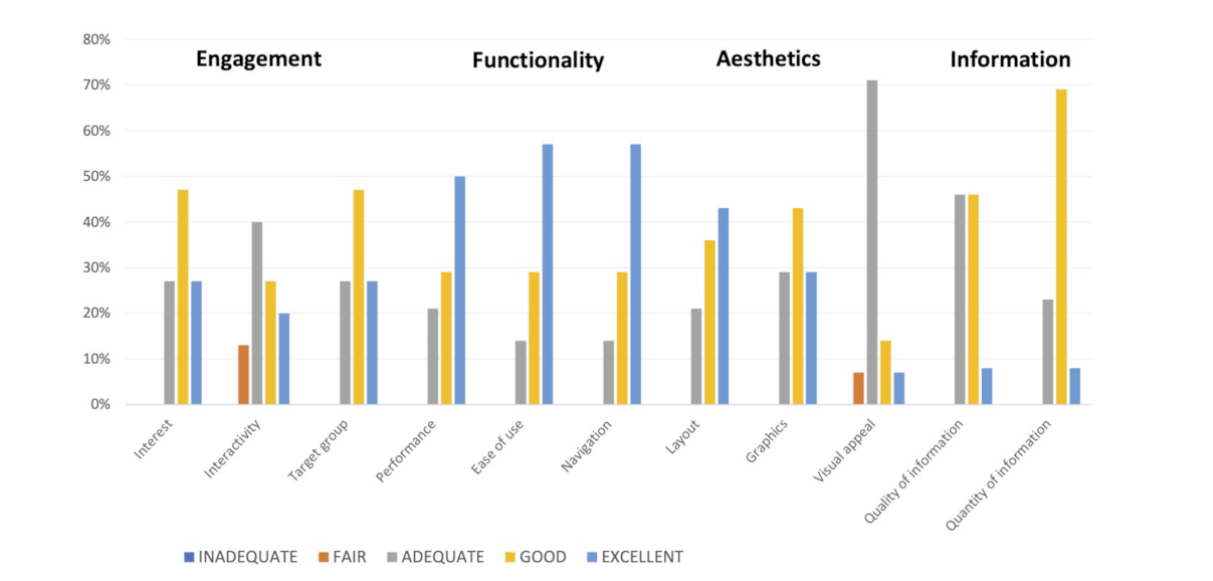
Figure 2. mMARS – Perceived Usability of Rose.